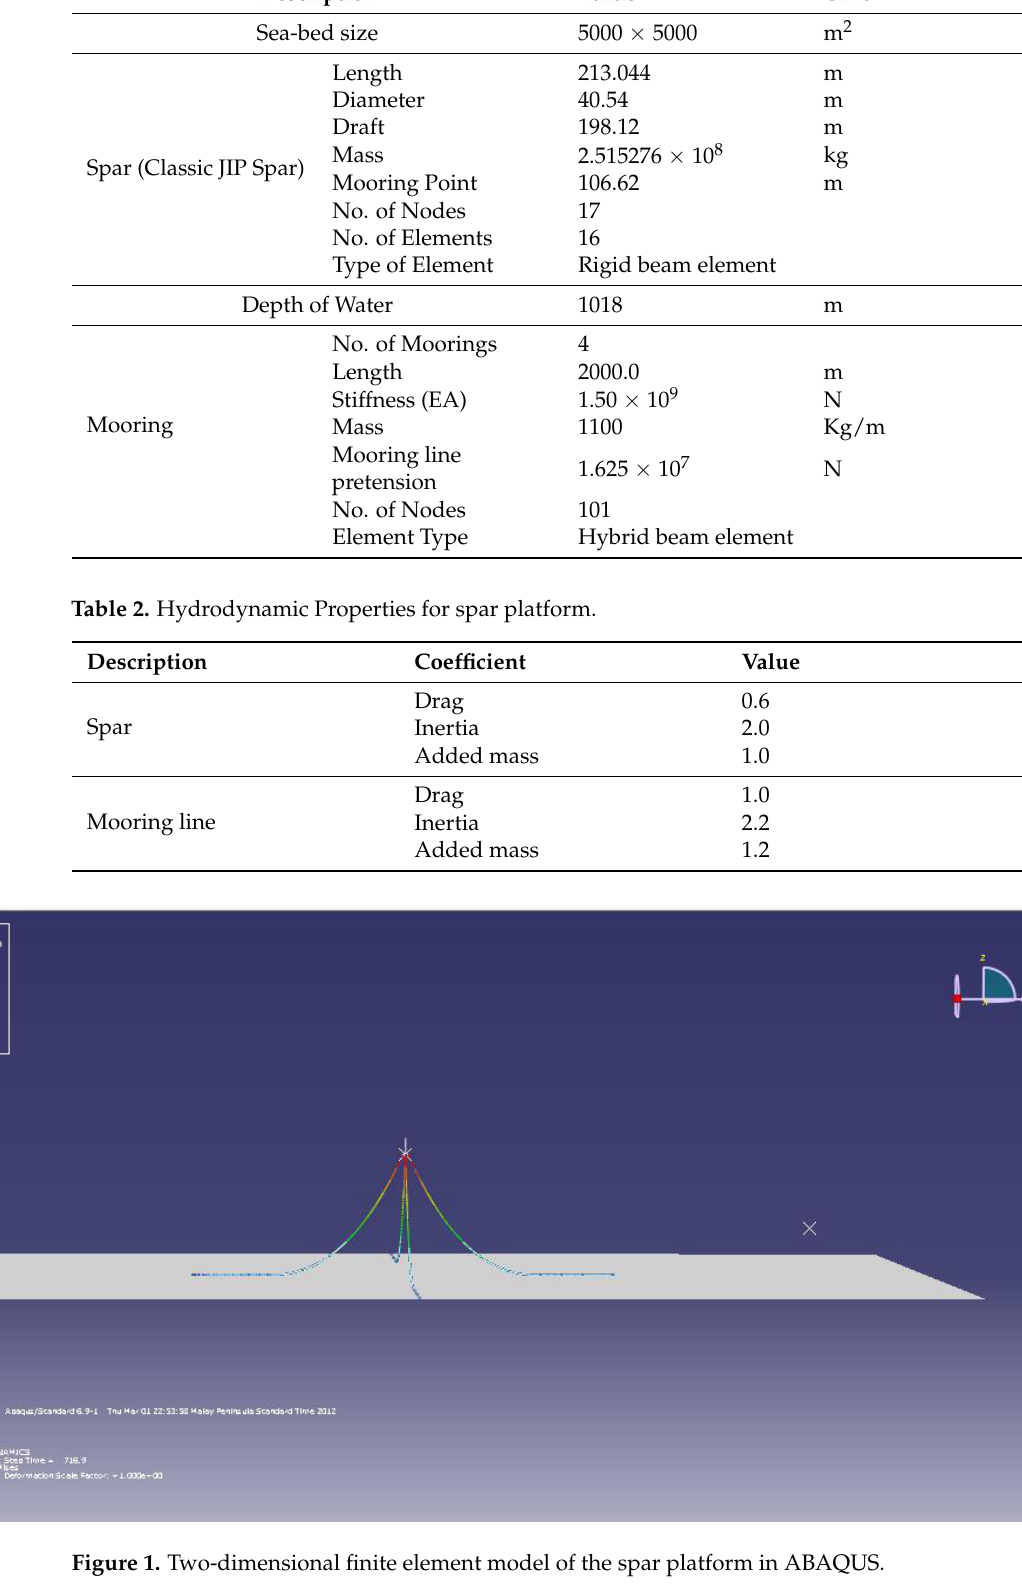
Table 1. Geometrical and mechanical properties of moorings and spar hull. Table 2. Hydrodynamic Properties for spar platform.